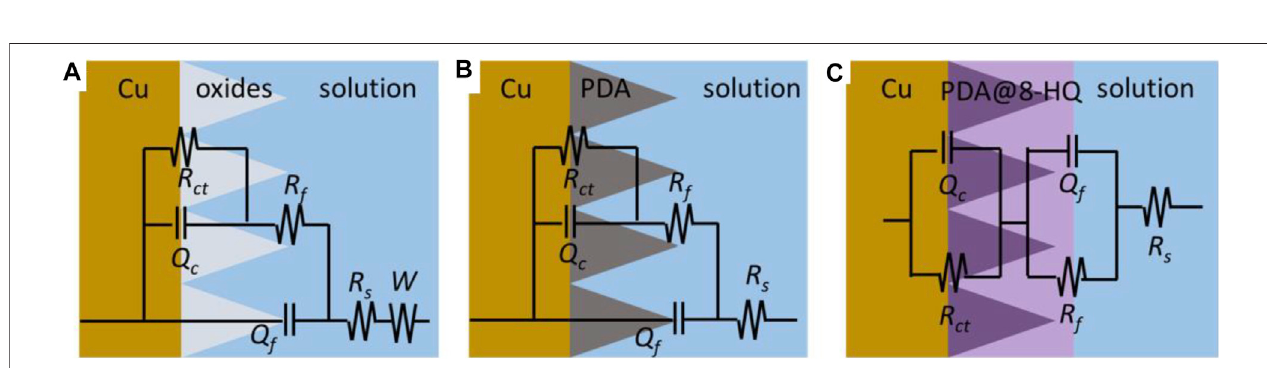
FIGURE 6 | Electrochemical equivalent circuits simulated for the impedance of the (A) bare copper, (B) PDA@Cu, and (C) PDA@8-HQ@Cu.